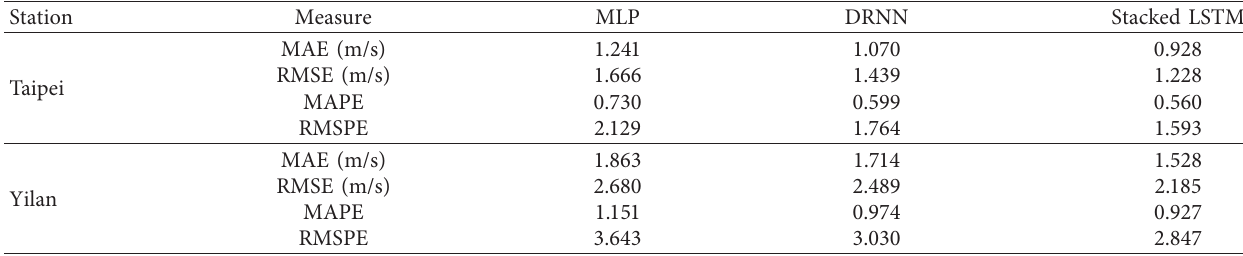
Table 2: Average performance measures of absolute error terms (MAE and RMSE) and relative error terms (MAPE and RMSPE) for 1–6h